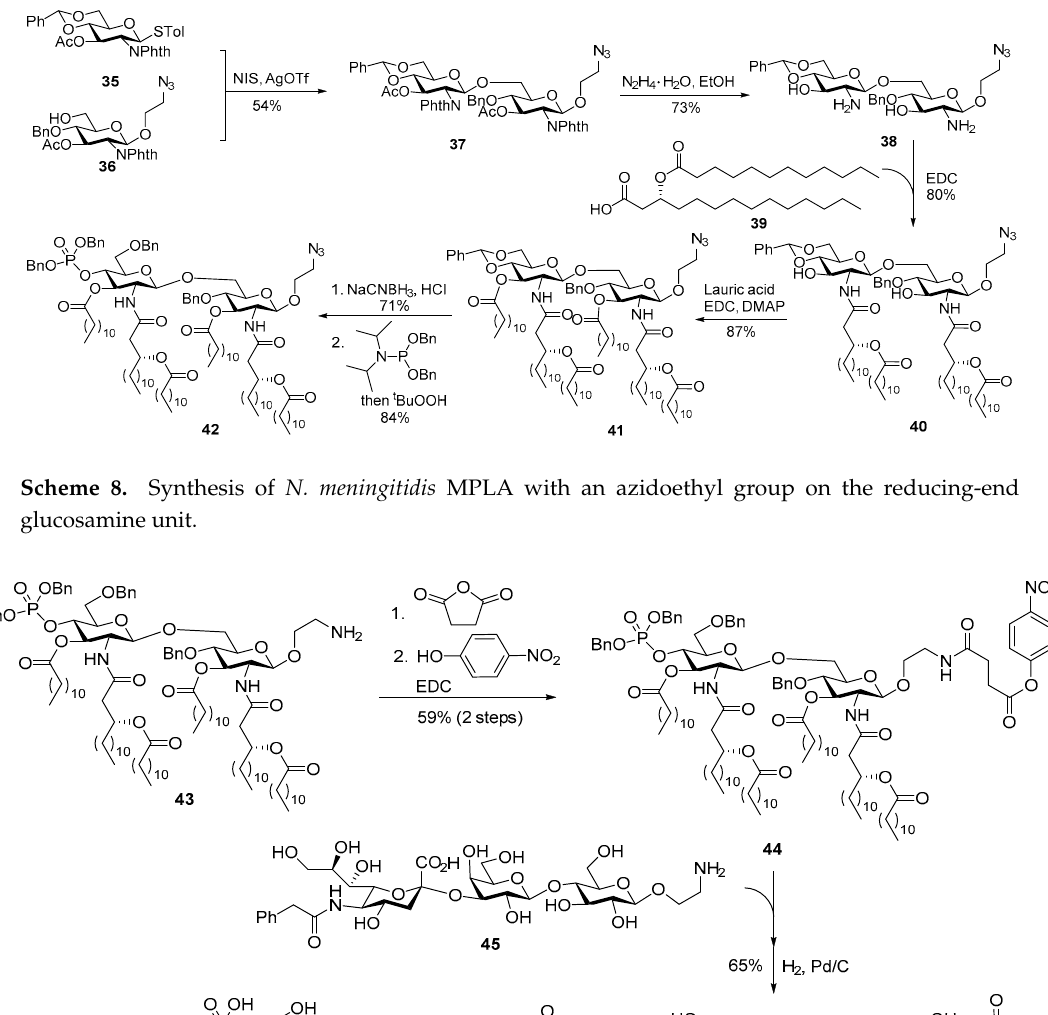
Figure 2. Conjugates of sTn antigen with MPLAs containing different lipid structures for SAR studies.